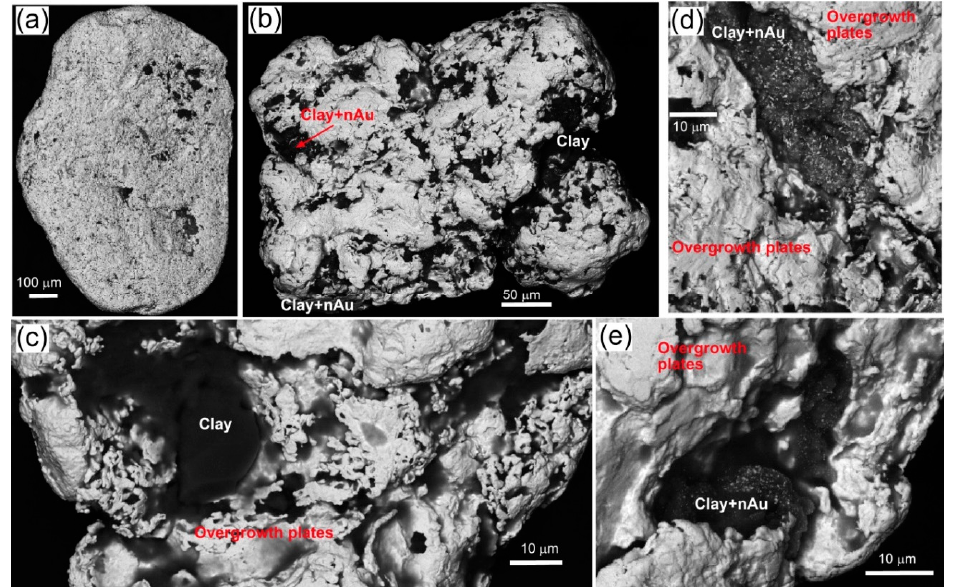
Figure 9. SEM backscatter electron images of surface features of detrital gold in Late Pleistocene sediments in the Drybread area (Figure 1a). ( a , b ) Typical transported detrital particles; ( c – e ) Authigenic gold has overgrown the detrital particles as plates and vermiform masses, and is commonly intergrown with authigenic clays (nanoparticulate gold = nAu).